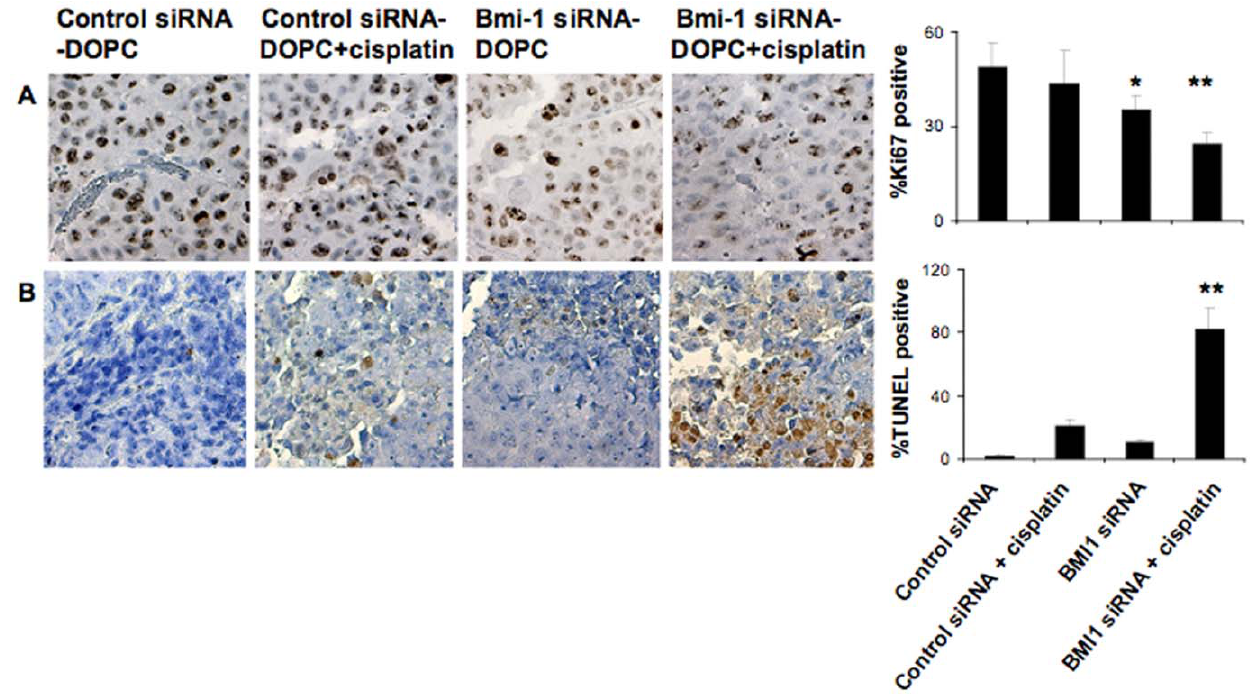
Figure 7. Knockdown of Bmi-1 leads to decreased proliferation and increased apoptosis of ovarian tumor in vivo . (A) Immunohistochemical staining for Ki67 and (B) TUNEL was conducted to assess cell proliferation and apoptosis. Original magnification 200X. Quantification is shown graphically on the right. Treatment arms were compared using Student’s t test and P # 0.05 was deemed statistically significant.